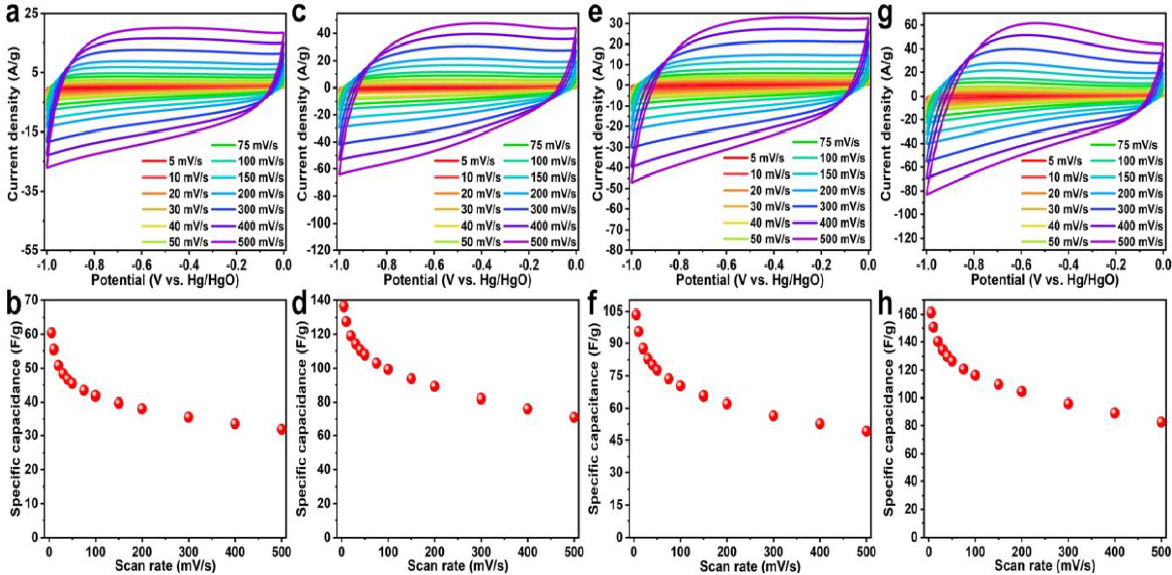
Figure 6. CV profiles and corresponding specific gravimetric capacitances at different scan rates of ( a , b ). C/SiO 2 , ( c , d ). [CNPIm][NTf 2 ]-based C/TiO 2 , ( e , f ). C/Nb 2 O 5 and ( g , h ). [CNPIm][NTf 2 ]-based pure C, respectively. Reprinted with permission from Ref. [68] 2022, John Wiley and Sons.